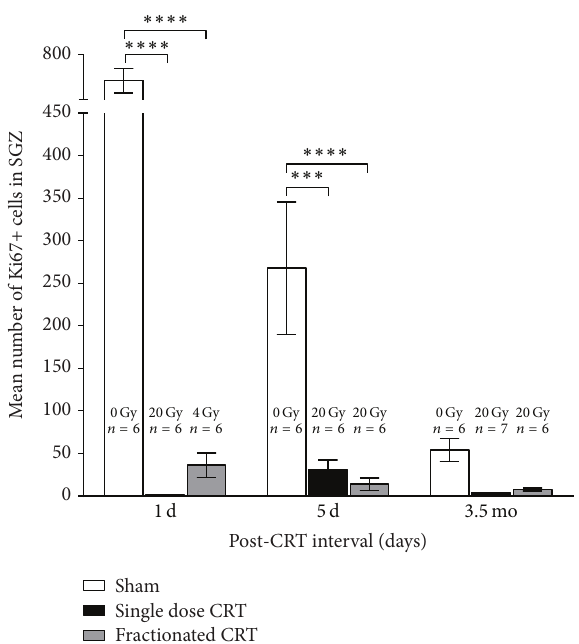
Figure 2: Mean number ( ± SEM) of Ki67+ cells in the SGZ 1 d, 5 d, and 3.5 mo after CRT [ ∗∗∗ 𝑝 < 0.001 , ∗∗∗∗ 𝑝 < 0.0001 ]. Note that all animals are age-matched at each post-CRT interval and that 24 hours after the start of radiation the single dose CRT and fractionated CRT groups differ only in terms of the cumulative dose of radiation received. The number of Ki67+ cells dropped significantly with age only in the shams.